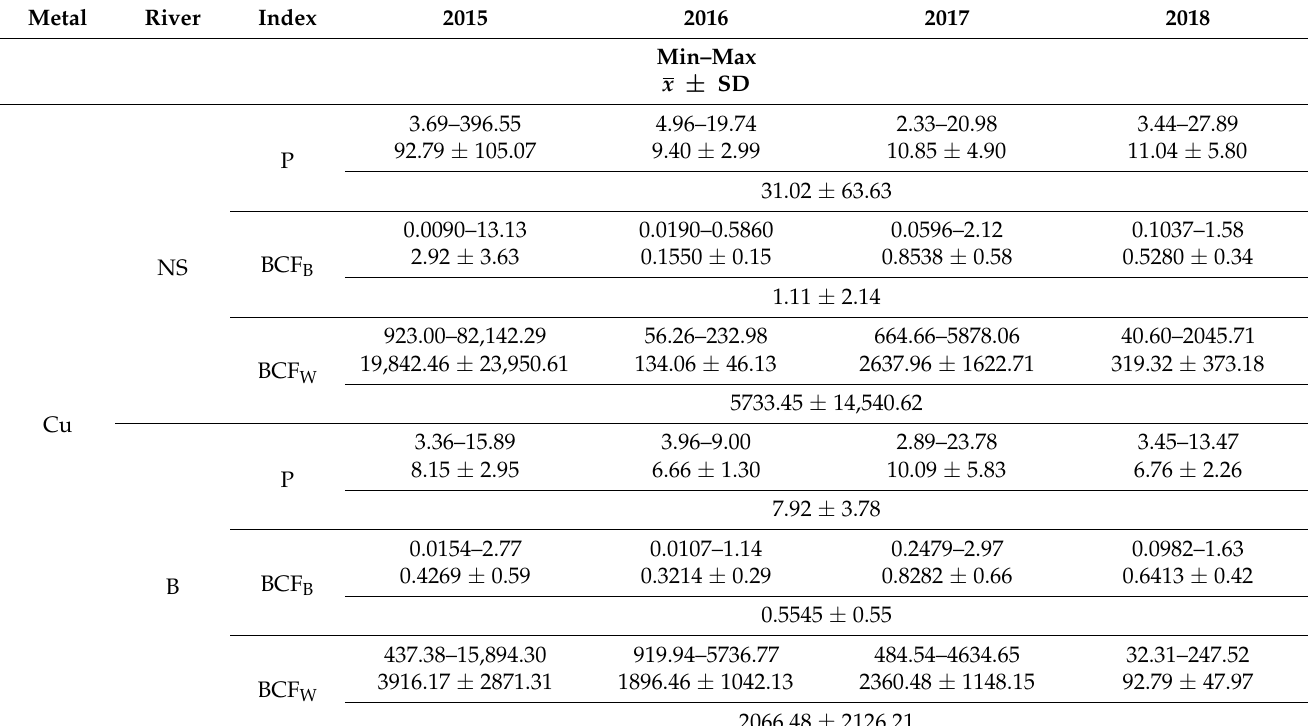
Table 5. Metal content (mg · kg − 1 ) of reed canary grass in three main rivers and their tributaries over a four-year study